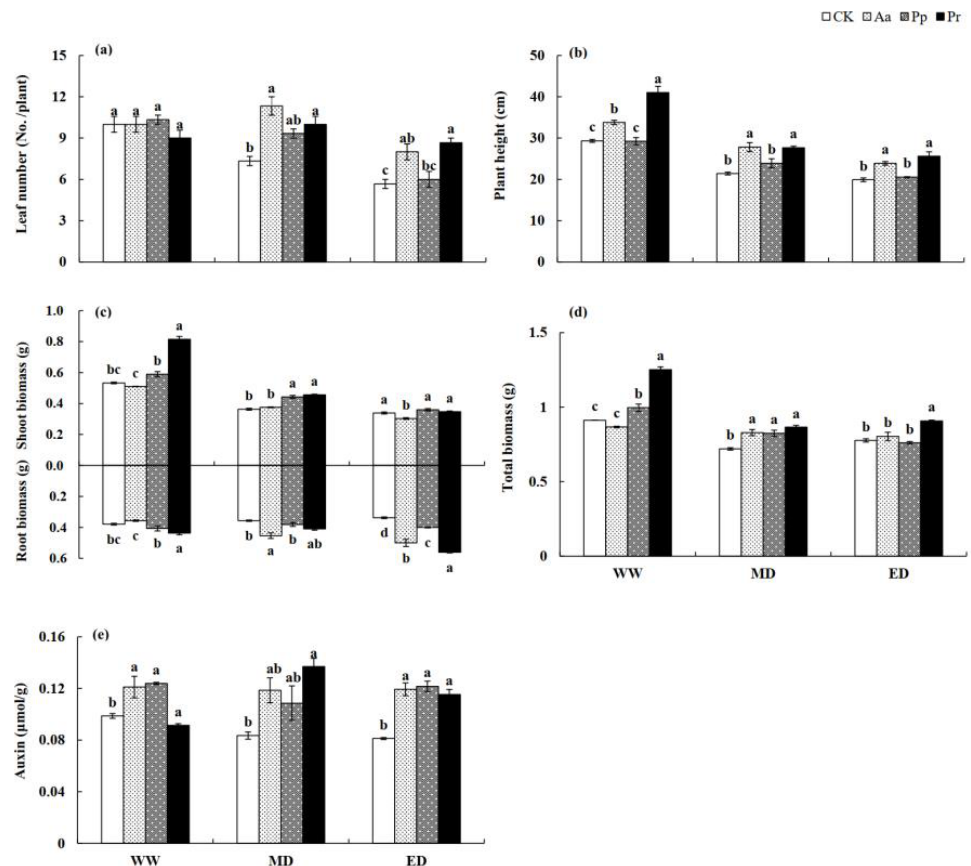
Figure 2. Influences of DSE on the growth parameters of wheat seedlings grown in different water conditions. ( a ) leaf number; ( b ) plant height; ( c ) shoot and root biomass; ( d ) total biomass; ( e ) auxin content. Different letters under a certain water condition indicate significant differences among the